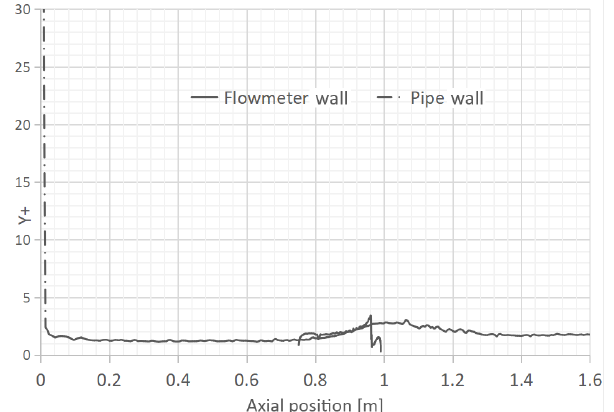
Figure 9. y + trend in the flowmeter and pipe walls’ proximity, PG